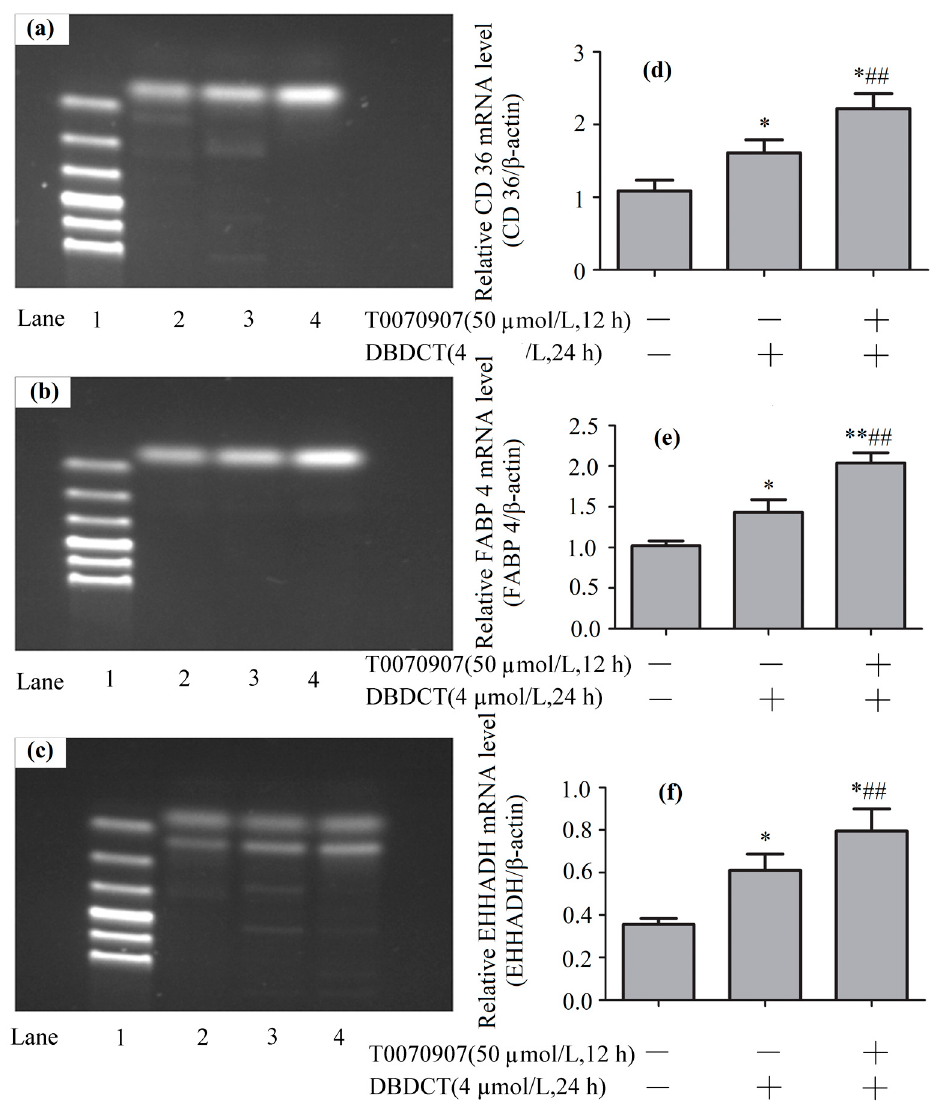
Figure 9. The CD36, FABP4 and EHHADH expression levels of mRNA in BRL cells with the treatment of T0070907 (50 μ mol/L) and DBDCT (4 μ mol/L). ( a – c ) The RT-PCR results of CD36, FABP4 and EHHADH (Lanes 1–4: Marker, Control, 4 μ mol/L of DBDCT, and 50 μ mol/L of T0070907 + 4 μ mol/L of DBDCT); ( d – f ) Relative mRNA levels of the targets in BRL cells. The results are expressed as a ratio of the expression levels of the reference mRNA of β -actin (* p < 0.05; ** p < 0.01; compared with control group; ## p < 0.01; compared with control group).